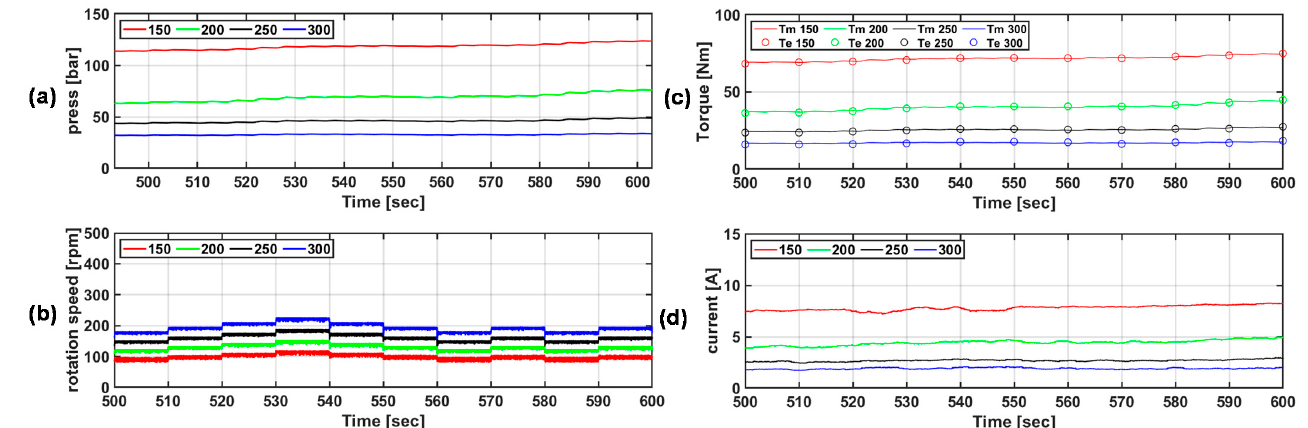
Figure 18. ( a ) Pressure in the circuit, ( b ) hydraulic motor rpm, ( c ) mechanical and electrical torque, and ( d ) load current according to the initial rpm of the speed control algorithm under irregular wave conditions ( H s = 0.75 m, T p = 4.75 s) (legend indicates initial rpm).